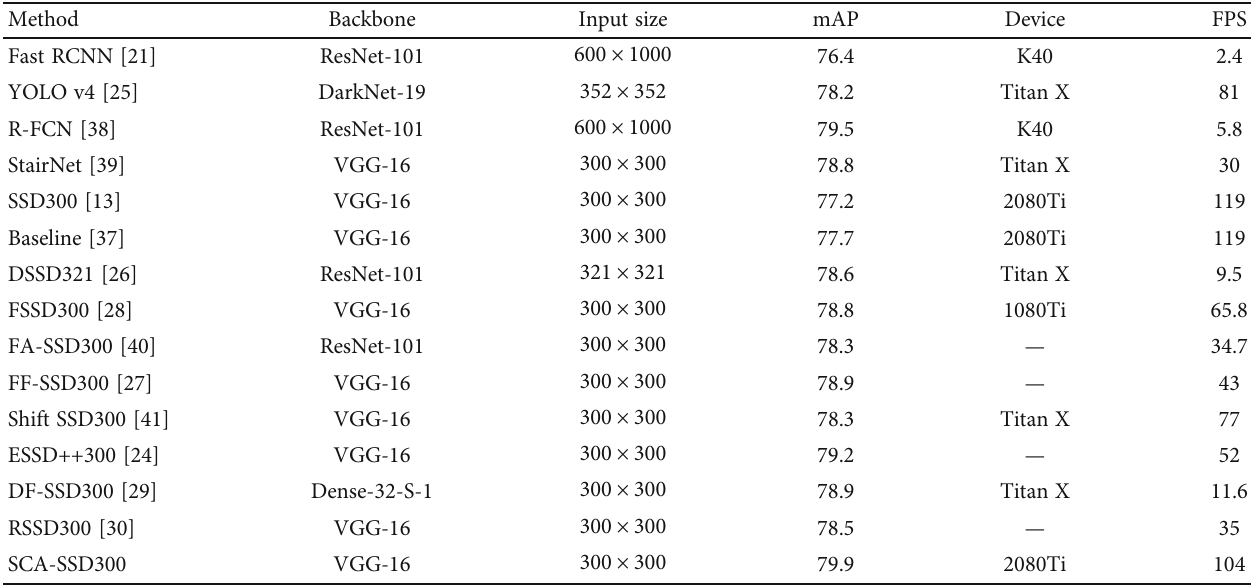
Table 3: Comparison of object detection methods on VOC 2007 and VOC 2012 test dataset. In this table, the SCA-SSD is compared with some state-of-the-art methods and other SSD-based methods to illustrate the promising performance on object detection.